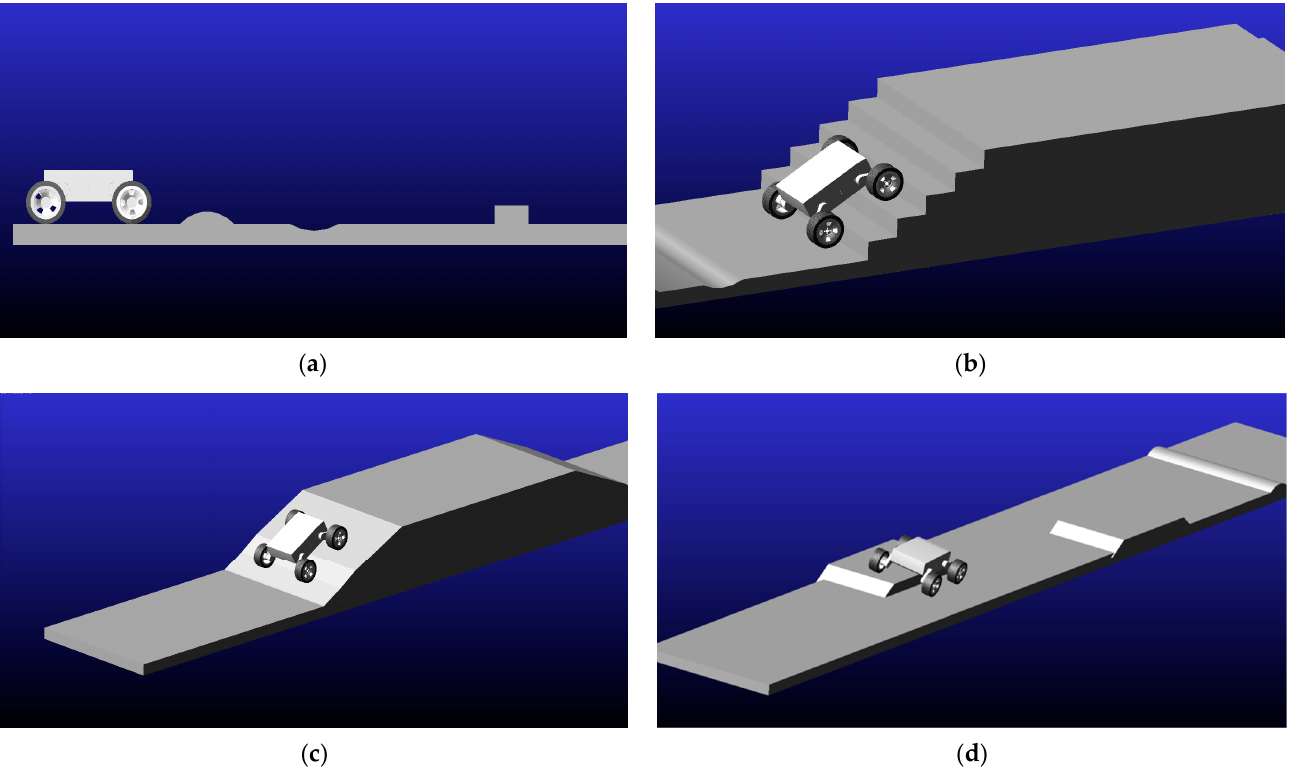
Figure 8. ADAMS simulation diagram: ( a ) simulation drawing of crossing complex road surface; ( b ) simulation drawing of climbing stairs; ( c ) simulation drawing of moving in sloped terrain; ( d ) simulation drawing of both sides continuous obstacle crossing.